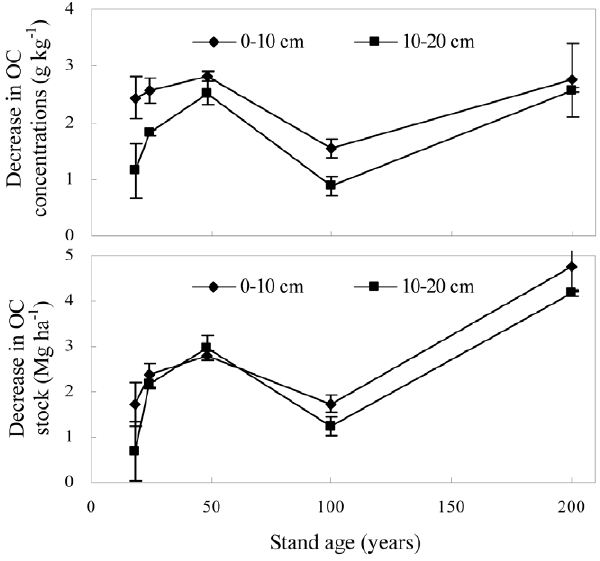
Figure 9. The decrease in OC concentration and OC stock in soils after afforestation of farmland (the error bars are standard deviation of the means).